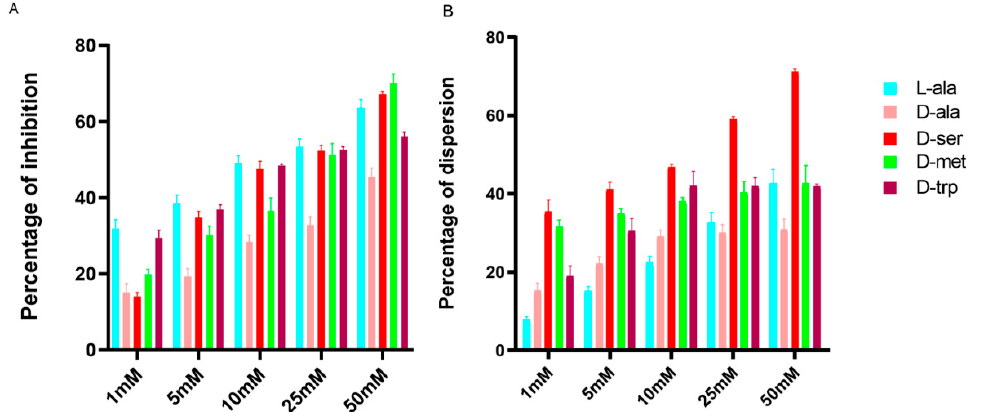
Figure 2. Inhibition and dispersion response of C. jejuni 11168-O biofilms in the presence of LAs and DAs at different concentrations. ( A ) Inhibition of biofilm formation by different concentrations of LAs and DAs, ( B ) Dispersion of the existing biofilm induced by different concentrations of LAs and DAs. The data is presented as Mean ± Standard errors of Percentage of inhibition (Normalized to untreated control).